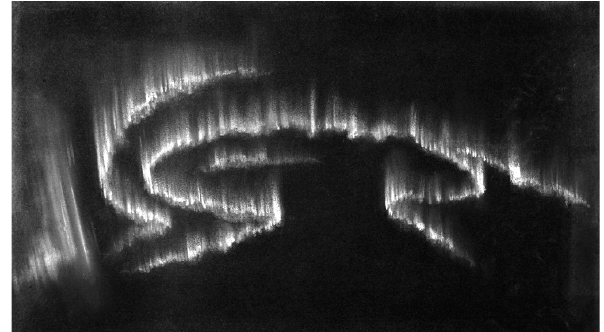
Figure 5. Tromholt’s photo of his drawing of an auroral display (“auroral break-up”) observed at 07:55p.m. on 6 October 1882 (Tromholt, photo from UBB collection).